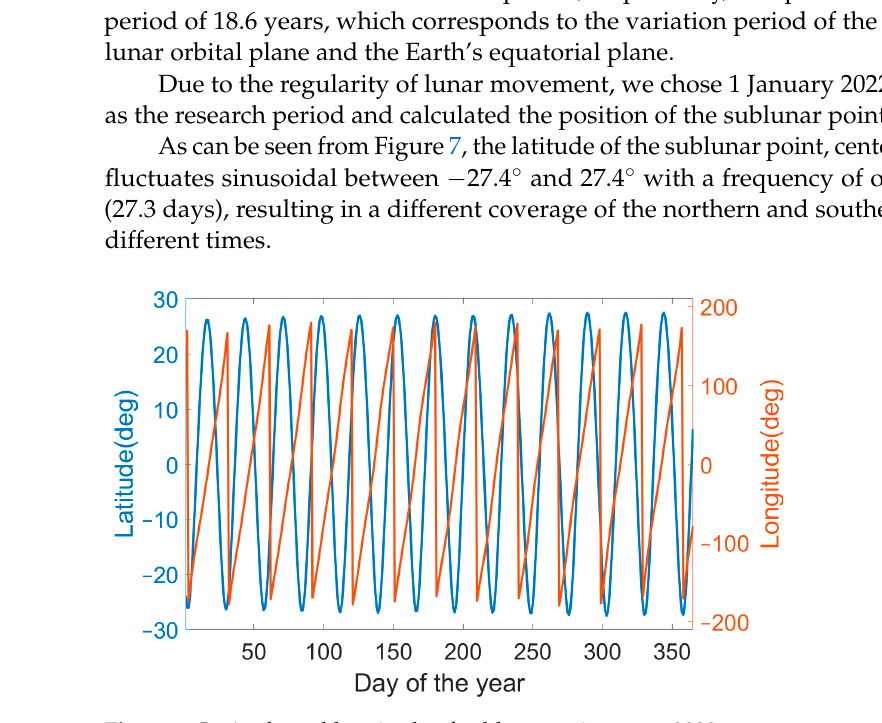
Figure 6. Position of sublunar points from 19802022: ( a ) latitude; ( b ) longitude.